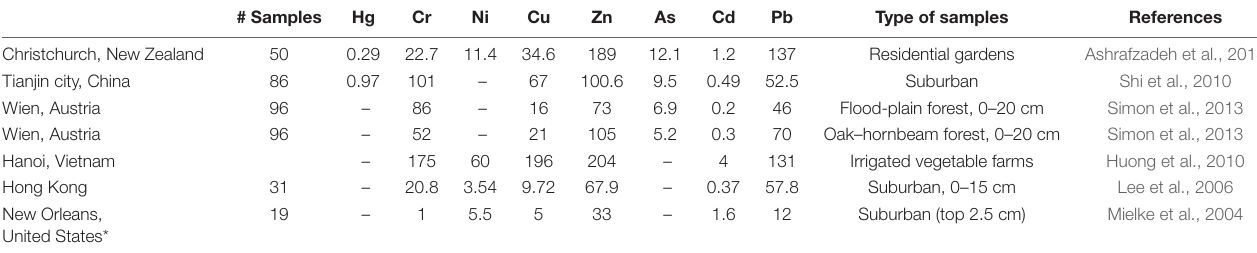
TABLE 2 | Comparison of mean trace elements concentrations in suburban soils in selected cities around the world (in mg kg − 1 ). #